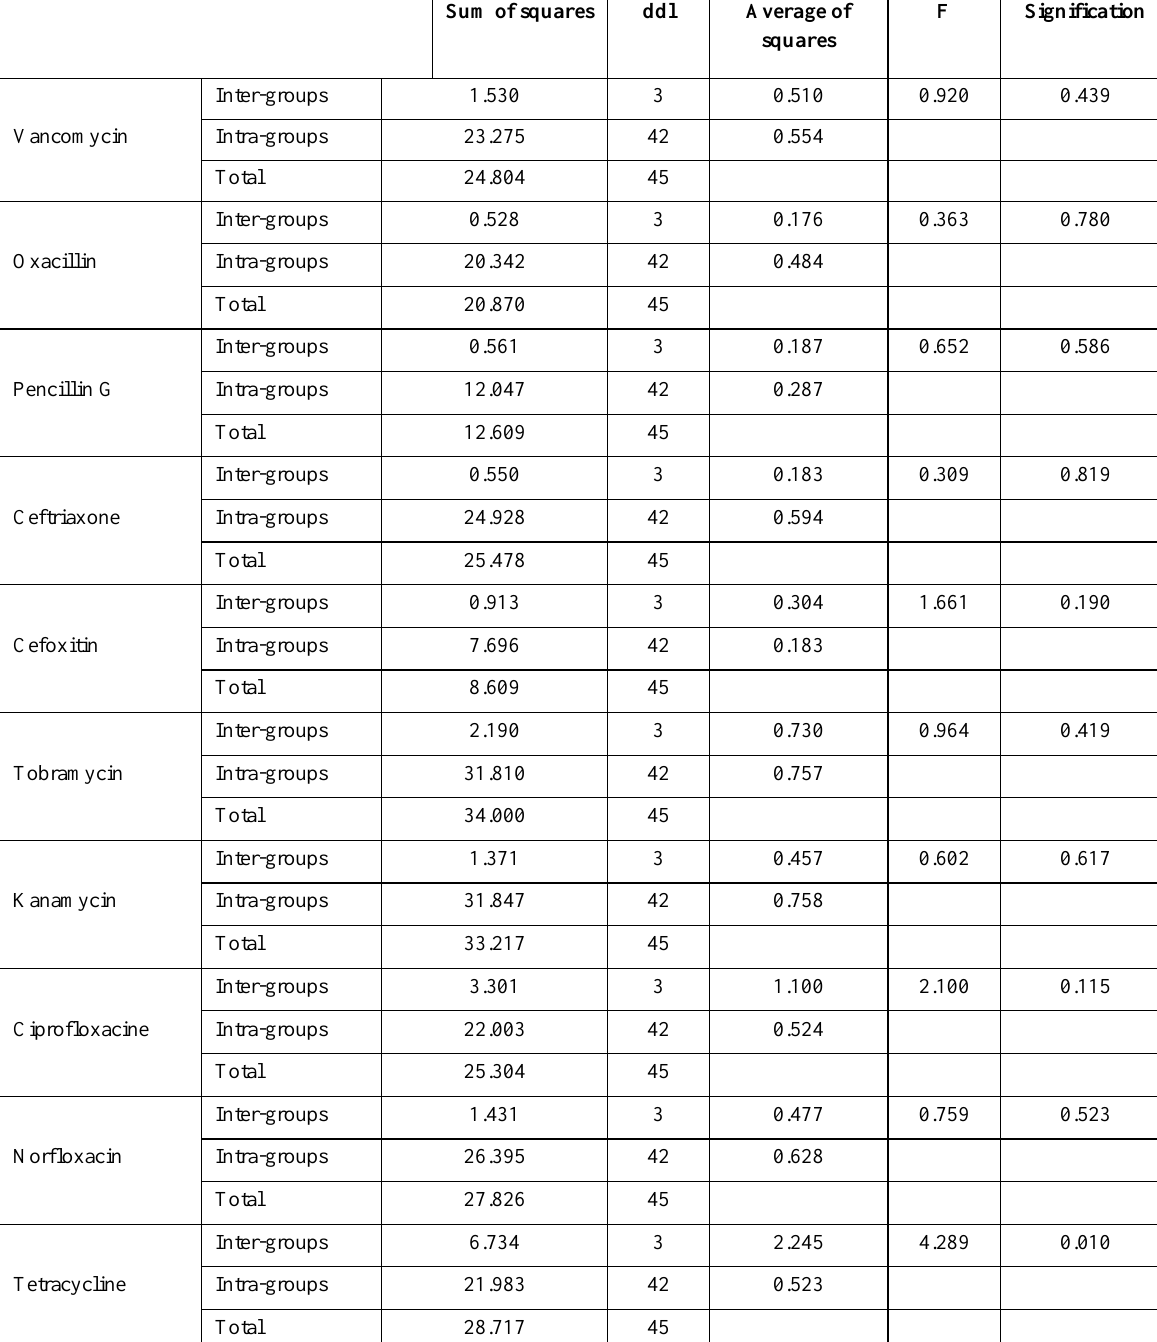
Table 2 : Analysis of variances (ANOVA) based on comparisons of antibiotic activities among environmental and clinical isolates of Staphylococcus